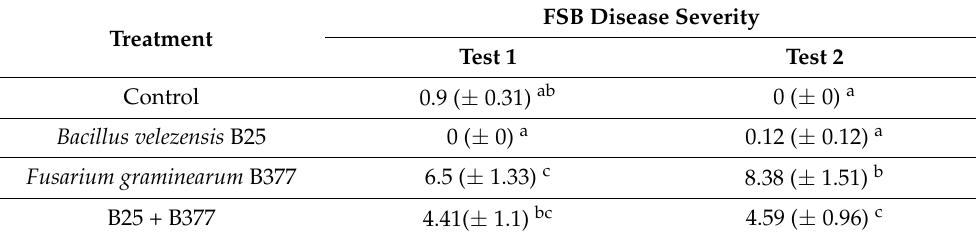
Table 4. Evaluation B. velezensis strain B25 biocontrol effect on fusarium seedling blight (FSB) syndrome caused by Fusarium graminearum B377. Different letters above the values (means ± standard deviation, n = 30) show significant differences in FSB disease severity according to one-way ANOVA, followed by Tukey post-hoc test.